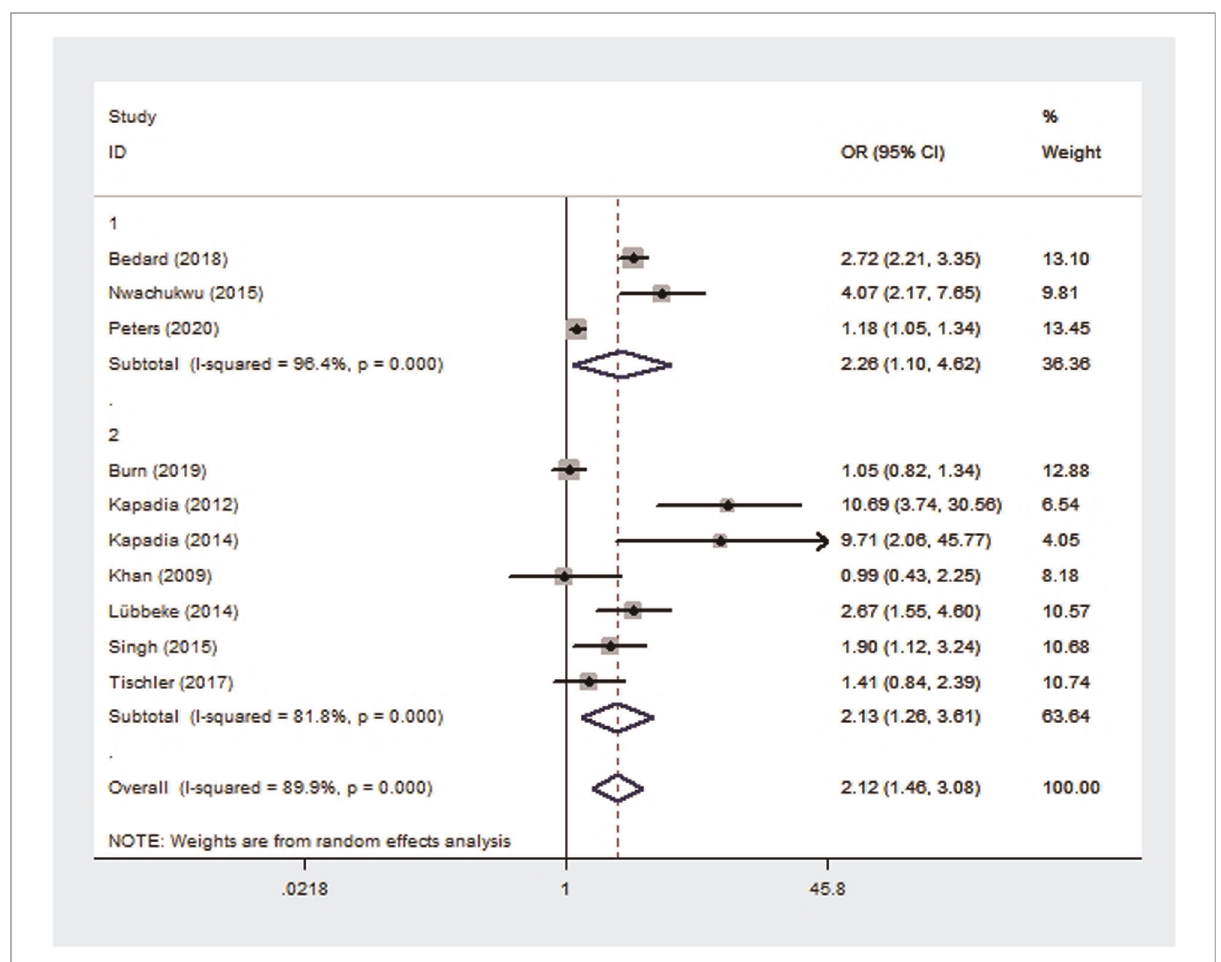
FIGURE 6 Forest plot of subgroup analysis for revision based on study type (1: case-control study; 2: cohort